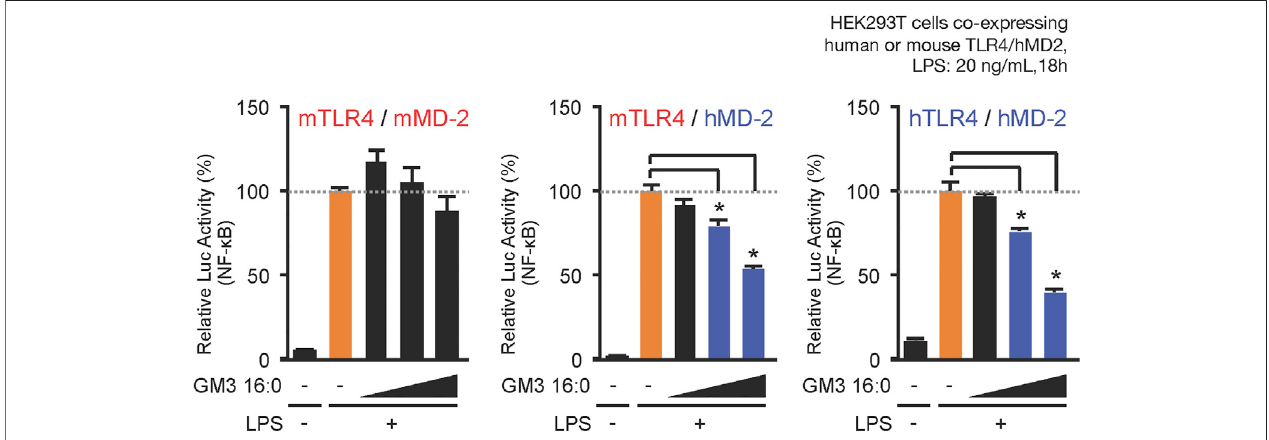
FIGURE 4 | MD-2 (hydrophobic pocket) is the basis for selectivity for acyl chains of GM3 species. Comparative inhibitory effects of GM3 16:0 on LPS-induced activation of mouse mTLR4/mMD-2 complex, human hTLR4/hMD-2 complex, and mTLR4/hMD-2 chimeric complex. Signal transduction was monitored by NF-kB reporter assay (Kanoh et al., 2020).